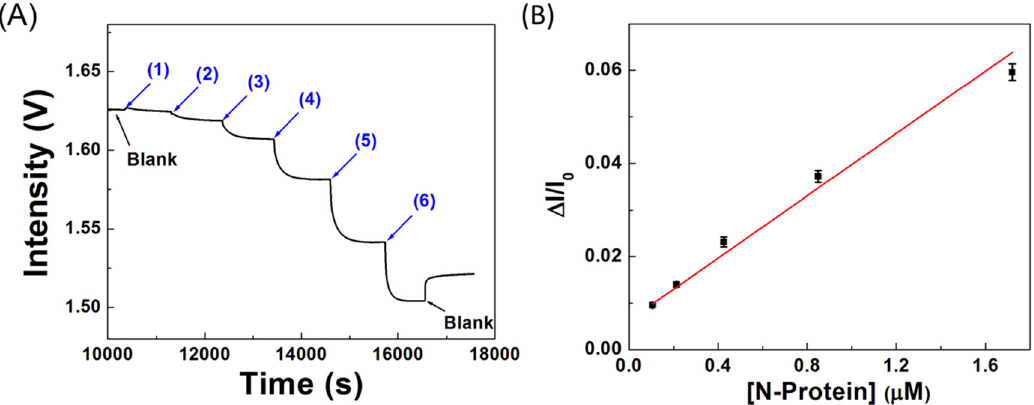
Figure 6. ( A ) Real-time sensorgram of sequentially pipetting standard N-protein solutions with different concentrations of ( 1 ) 53 nM, ( 2 ) 106 nM, ( 3 ) 212 nM, ( 4 ) 424 nM, ( 5 ) 848 nM, and ( 6 ) 1.7 μ M to a NP-A48 aptamer-functionalized sensor chip; ( B ) the corresponding standard calibration curve ( n = 2).